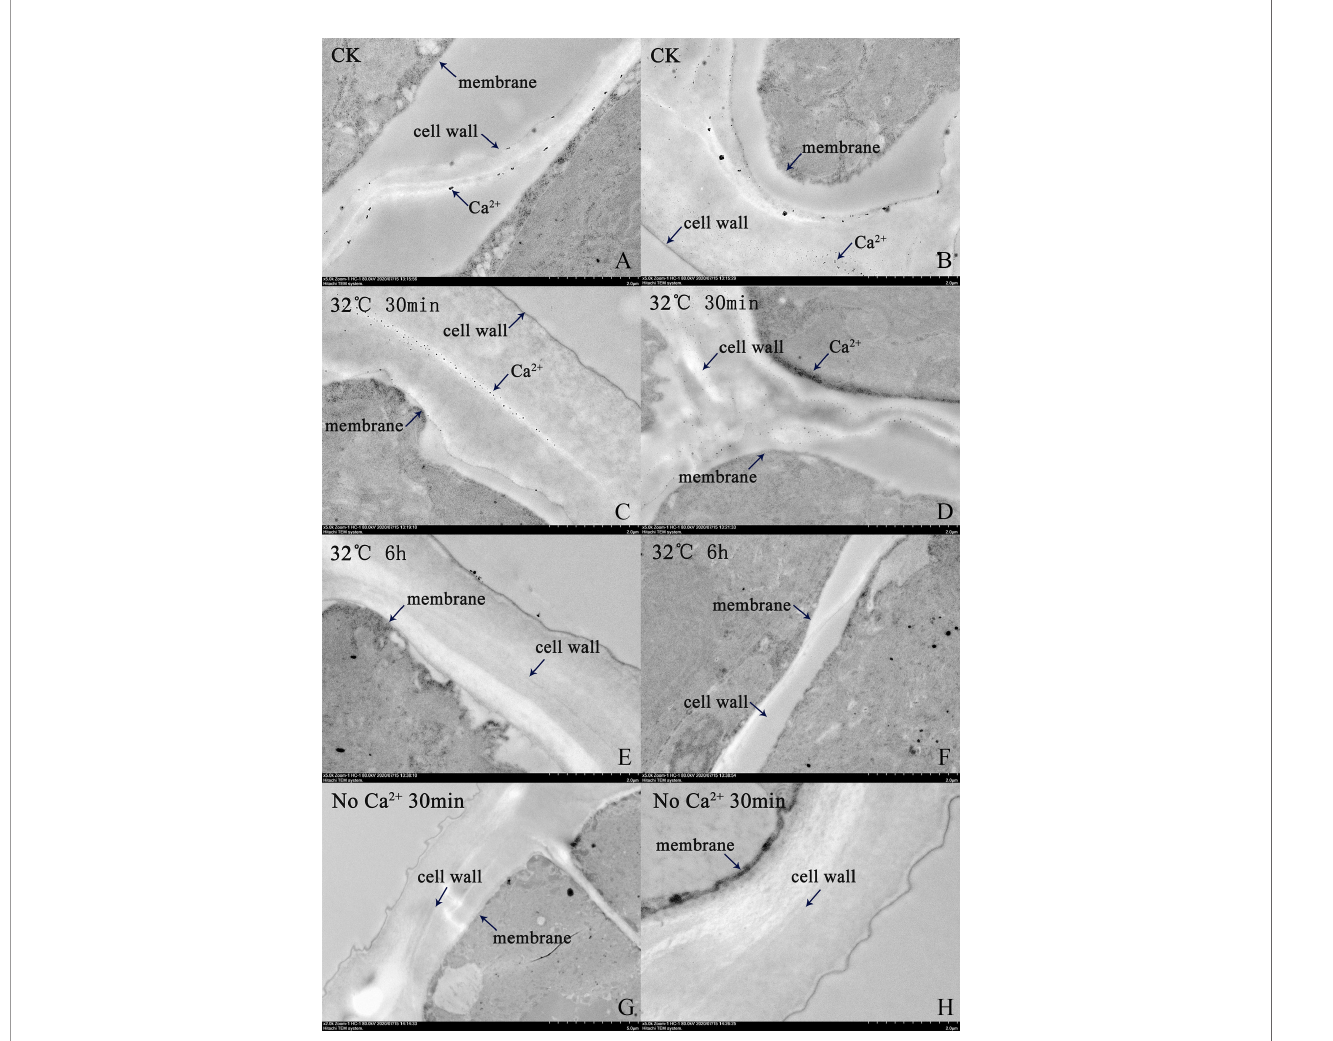
FIGURE 2 | Transmission electron micrographs showing distribution of Ca 2+ in N. haitanensis thalli under heat stress. (A, B) Control group. (C, D) Heat treatment for 30 min. (E, F) Heat treatment for 6 h. (G, H) Heat treatment for 30 min in Ca 2+ -free